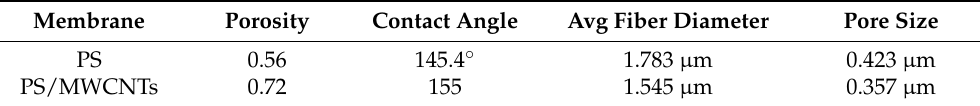
Table 2. Characteristic properties of the pristine and composite